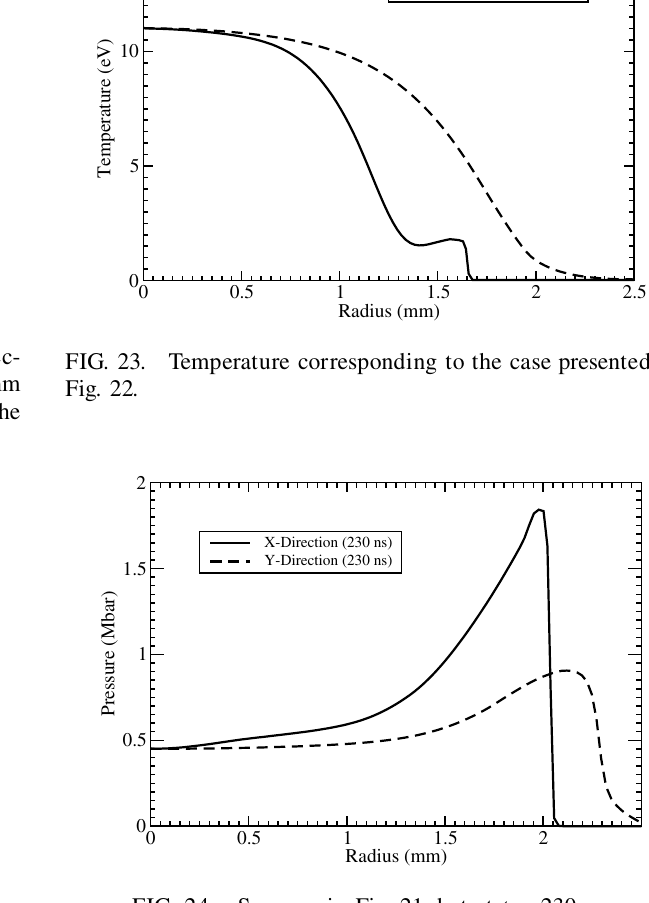
FIG. 24. Same as in Fig. 21, but at t (cid:3) 230 ns .